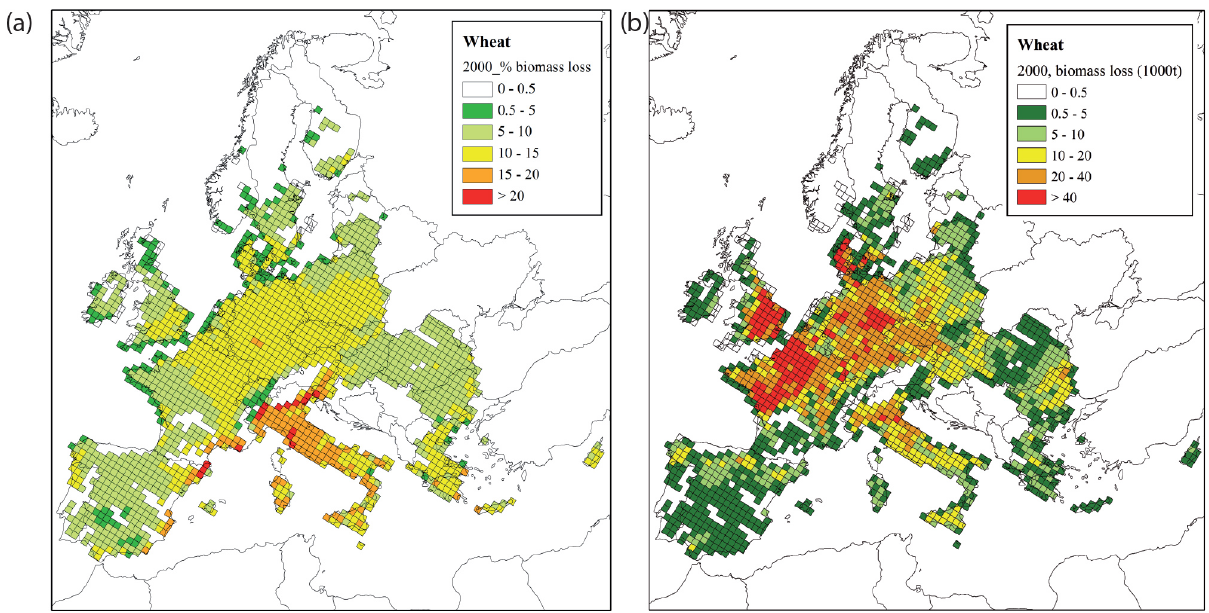
Figure 6. Geographical distribution of ozone effects on wheat biomass over Europe based on results from the EMEP MSC-W model for the year 2000: (a) percentage losses in biomass and (b) , effects on total above-ground biomass per 50 × 50km grid